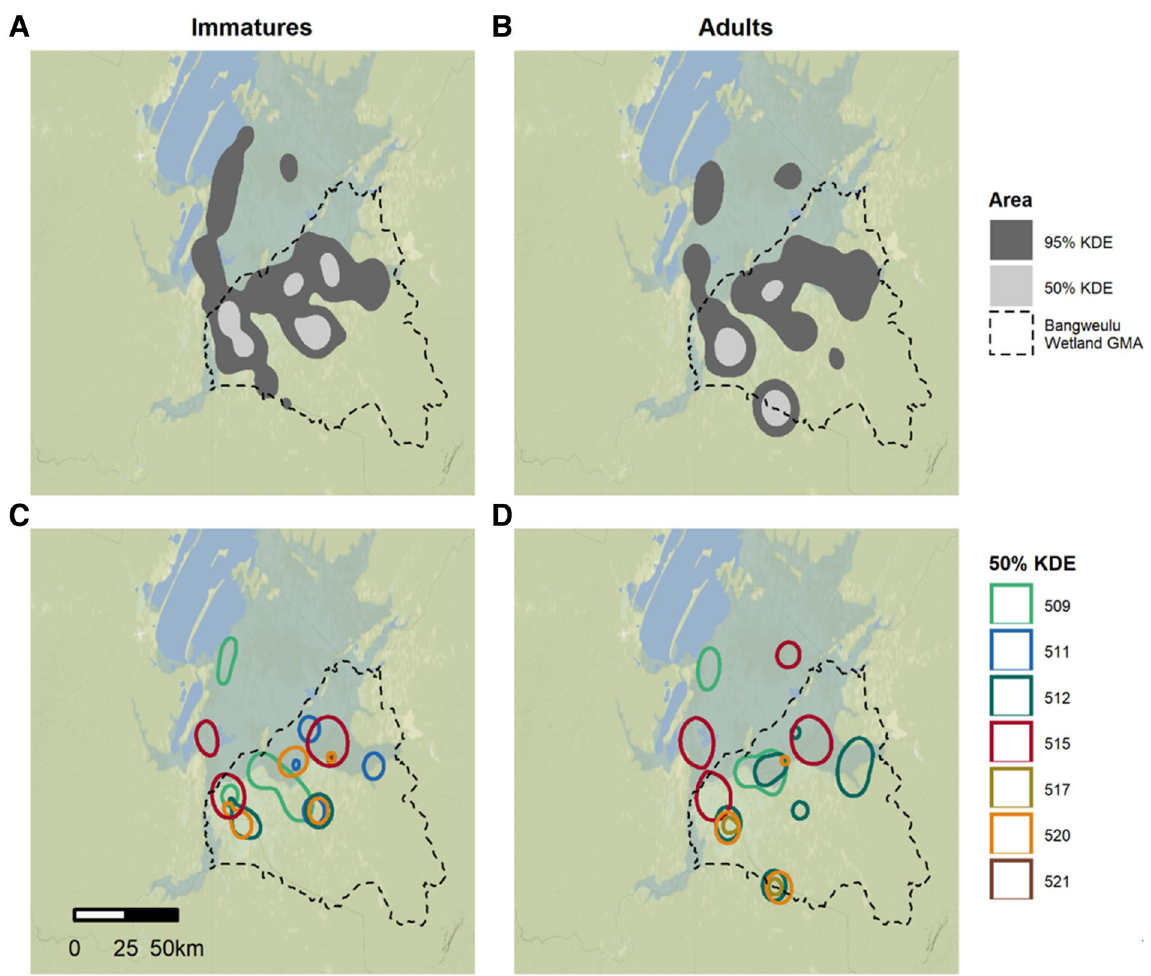
Figure 1. Cumulative 95% and 50% kernel density estimations for all tracked (A) immature and (B) adult Shoebills, and cumulative 50% kernel density estimation for each (C) immature and (D) adult individual, based on the GPS tracking periods indicated in Table 1. The dashed line indicates the border of the Bangweulu Wetlands Game Management Area.